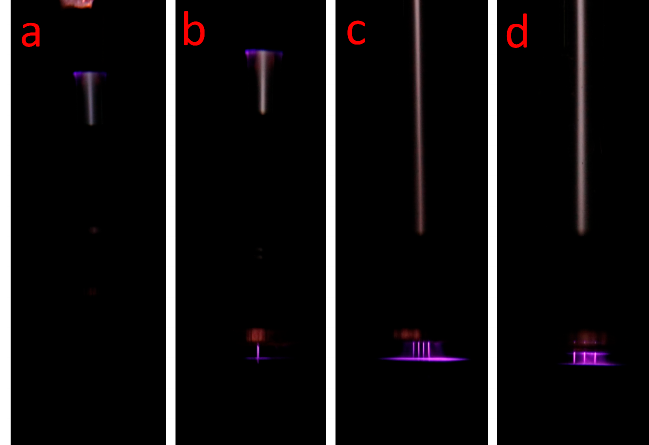
Figure 3. ( a ) Optical image of single plasma microjet without substrate and sliding platform no plasma plumes was seen by naked eyes; ( b , c ) optical image of single plasma microjet and 1 × 3 and 2 × 2 plasma microjets array in the dark condition; ( d ) discharge generated surround the 2 × 2 plasma microjets when the distance was close to 1 mm. Experiment conditions: applied voltage was 4.5 kV pp , 11 kHz; 700 sccm helium mixed with 7 sccm oxygen.